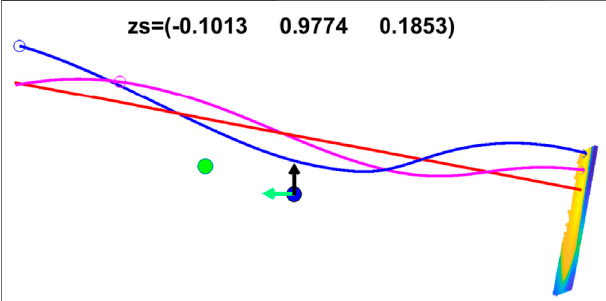
FIGURE4 | The 3D view toward the Sun (alongthe +GSE-X direction)of the selected fi eld lines (with arbitrary colors) from the GS reconstruction result corresponding to Figure 2 . The unit vectors of the GSE-Y and Z coordinates are denoted in green and black arrows, respectively. The cross section as seen in Figure 2B is shown to the right where the fi eld lines originate and spiral along the z axis. The red straight fi eld line originates from the center of the fl ux rope as marked in Figure 2B . The spacecraft locations of Wind and SOaremarkedbytheblueandgreendots,respectively.The z axisdirectionis denoted on top in the GSE